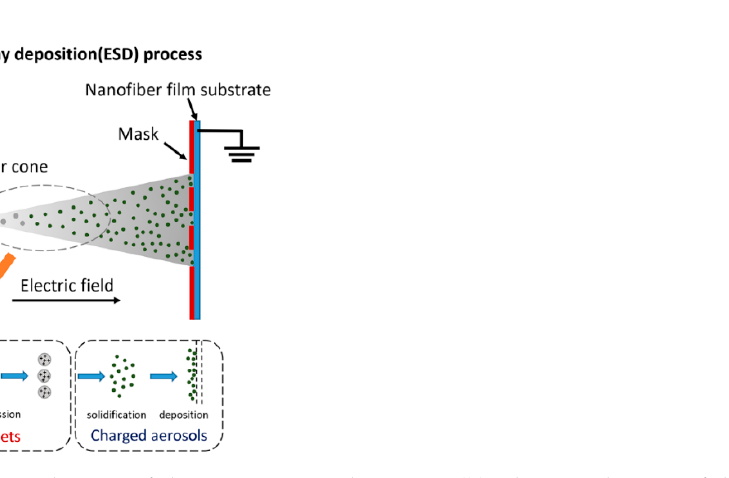
Figure 2. ( a ) Schematic diagram of electrostatic spray deposition; ( b ) Schematic diagram of charged aerosols generation and deposition process.